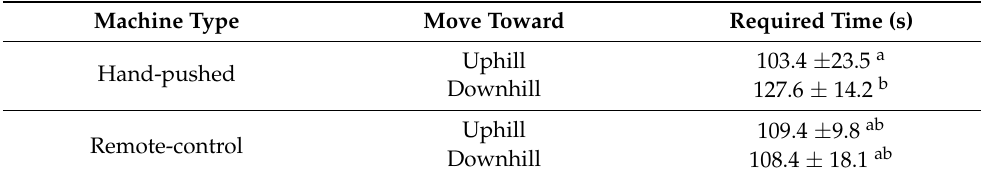
Table 3. Work time using different types of mini crawler